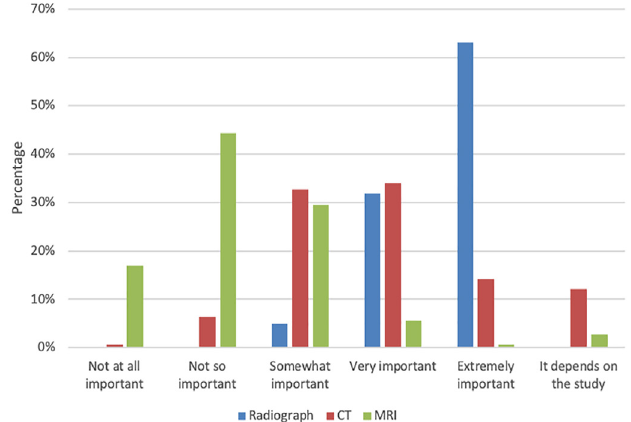
Figure. Perceived importance of independent interpretation of radiology studies. CT , computed tomography; MRI , magnetic resonance imaging.